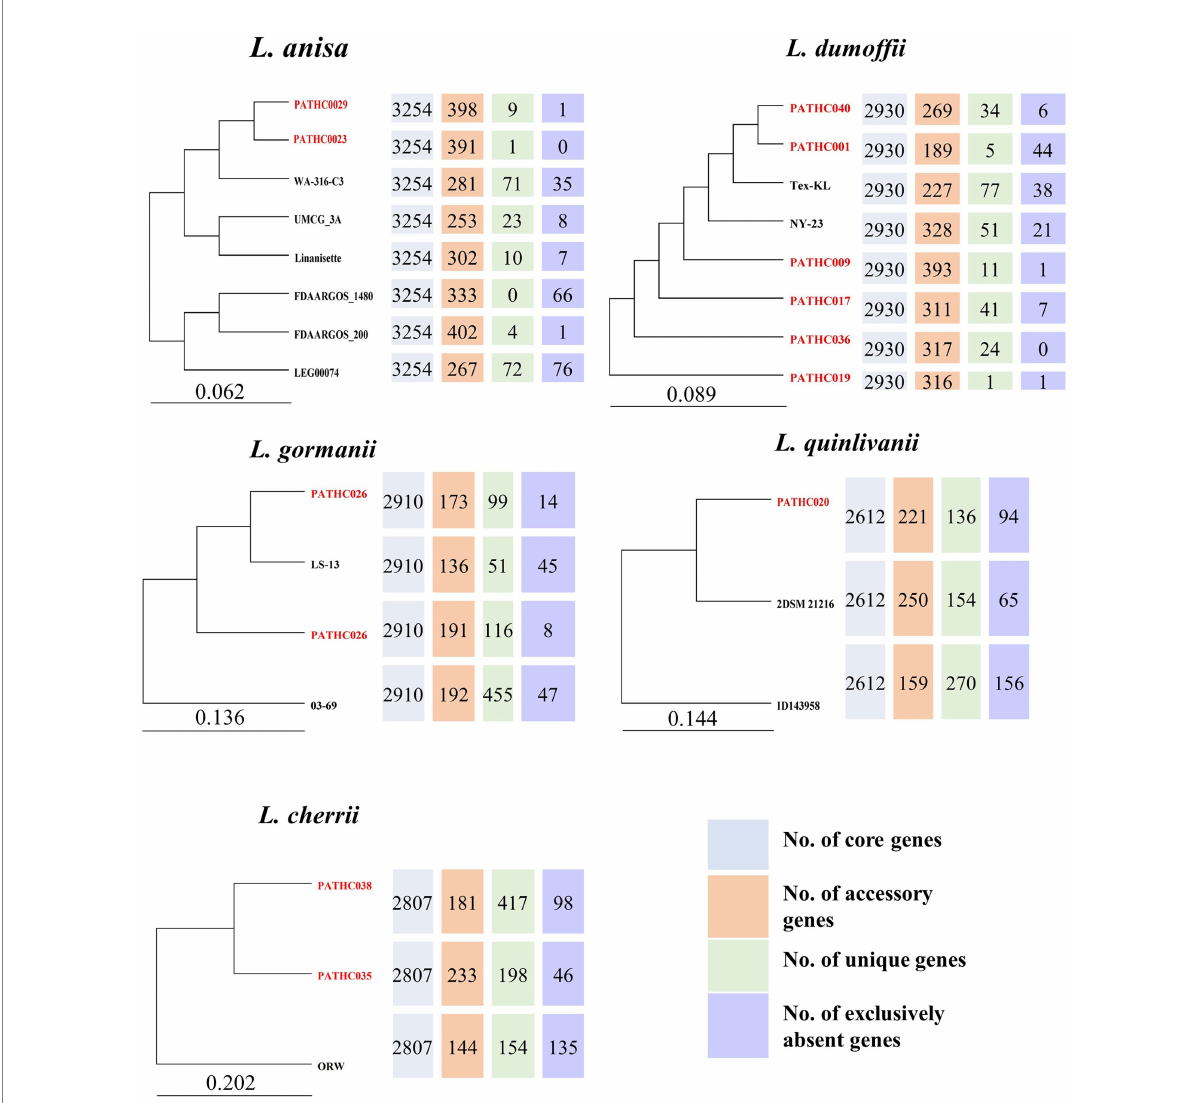
FIGURE 4 Comparative inter-species genome analysis of non-pneumophila genomes available from NCBI and genomes sequenced in this study. The pangenome trees were constructed with Bacterial Pan Genome Analysis Pipeline (BPGA). The number of core, accessory, unique, and exclusively absent genes was determined by the same